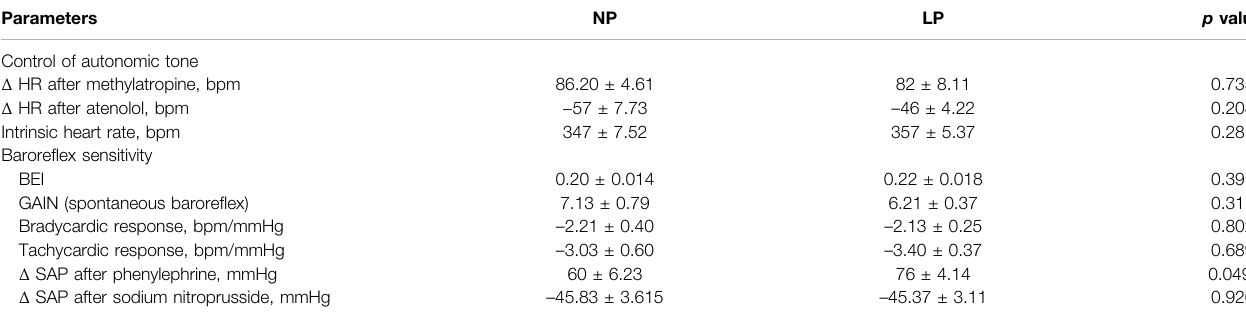
TABLE 4 | Cardiovascular autonomic evaluation after drug injection. Parameters